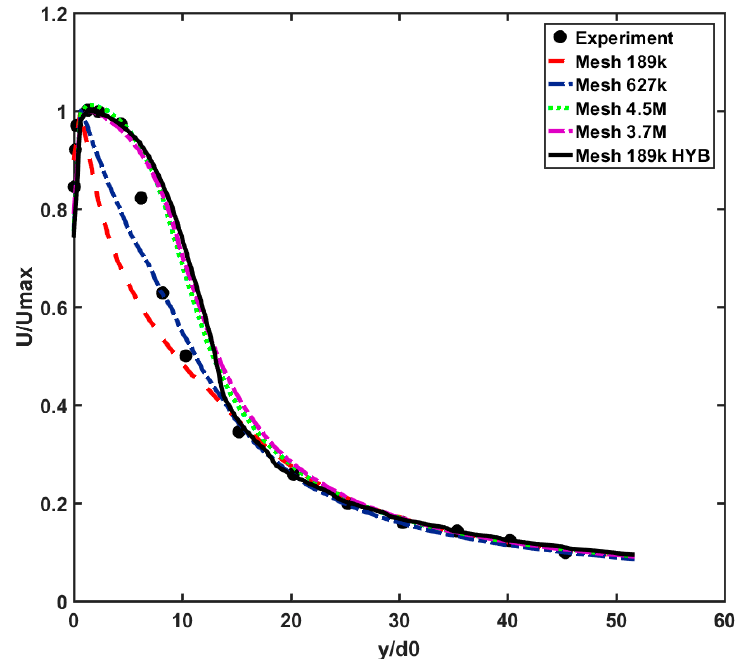
Figure 3. Comparison between centerline velocity of different mesh resolutions in present work with an experiment by [36]. an experiment by